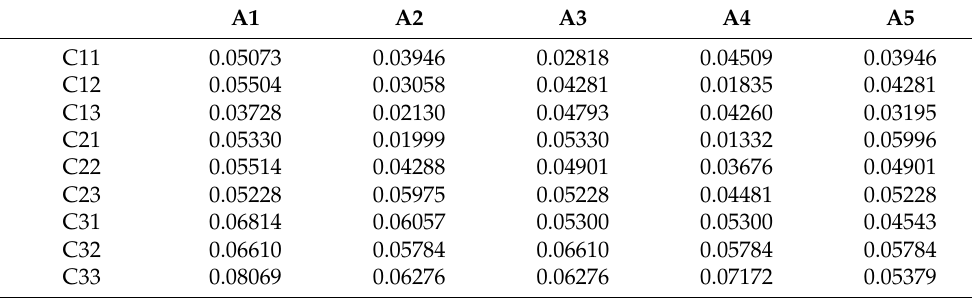
Table 6. Normalized weighted matrix.